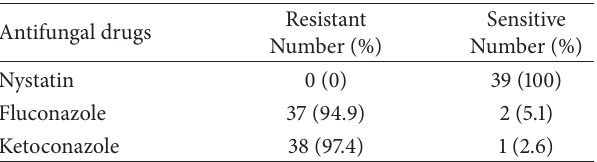
Table 3: Susceptibility and resistance of Candida albicans strains to antifungal drugs.